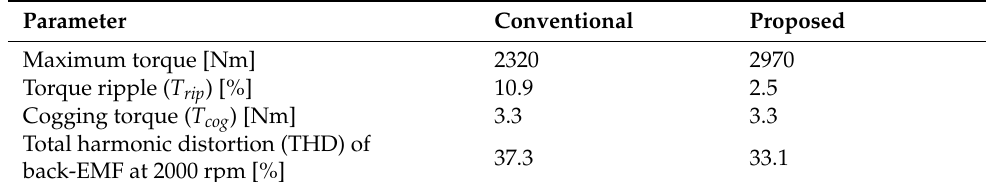
Table 3. Performance comparison between the conventional and proposed motor.